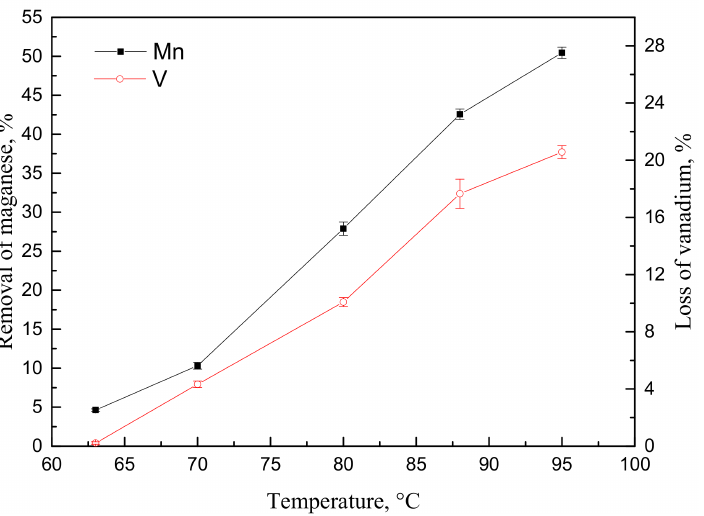
Figure 14. Effect of temperature on the removal of manganese and the loss of